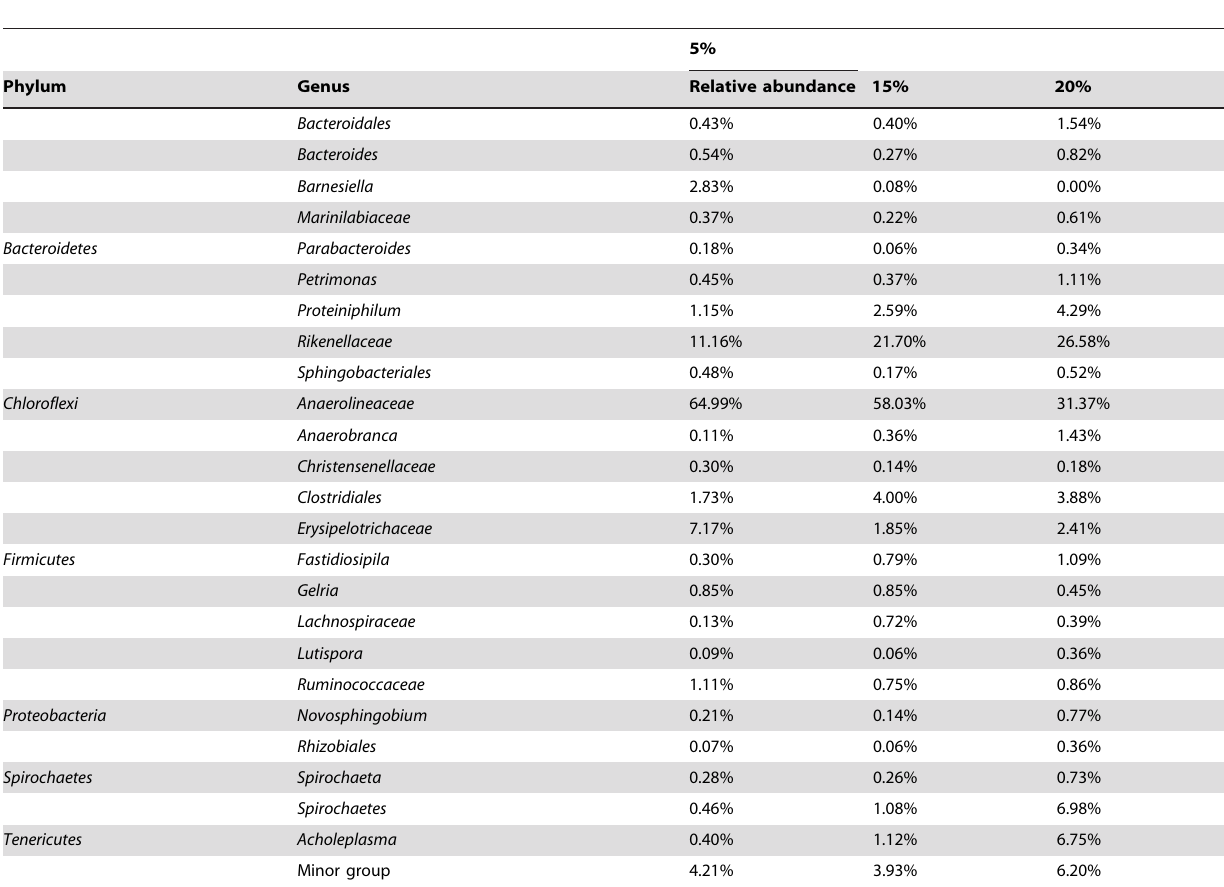
Table 4. Taxonomic composition of bacterial communities at the genus level for the sequences retrieved from each